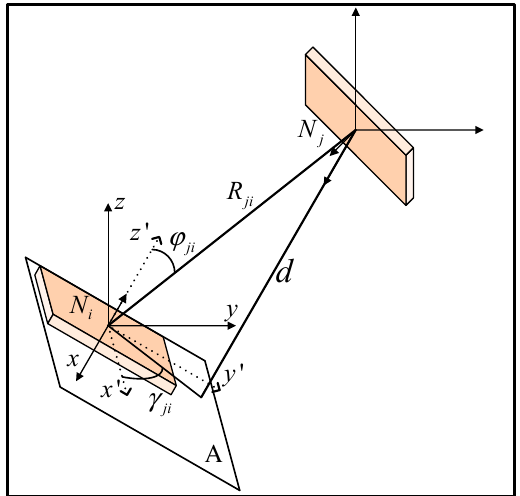
Figure 7. Calculation of the Received Signal Strength (RSS) between antennas.